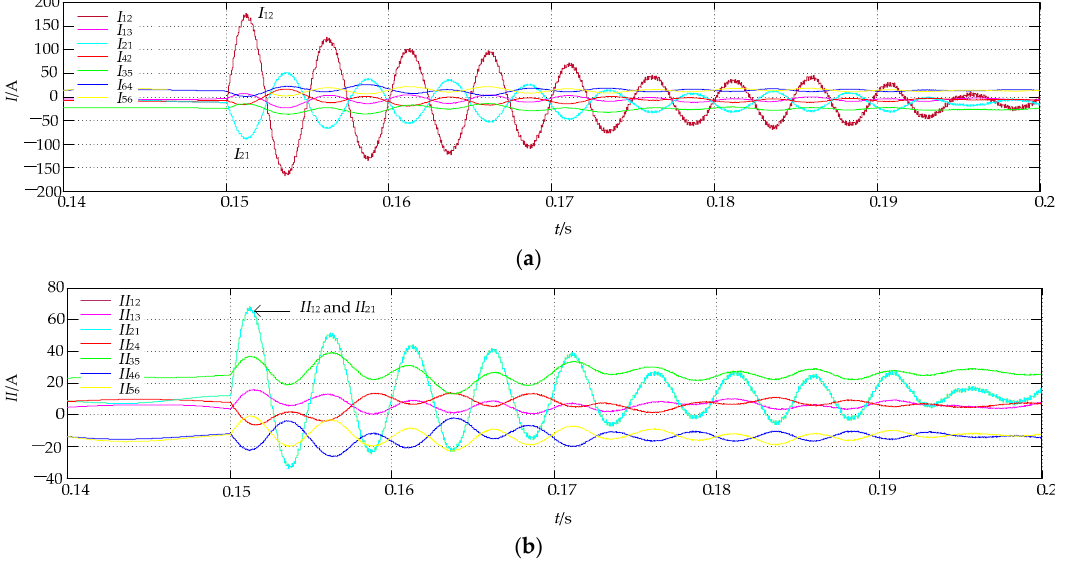
Figure 15. Pole ‐ to ‐ ground short ‐ circuit fault condition: ( a ) Positive line current conditions; ( b ) Negative line current conditions.